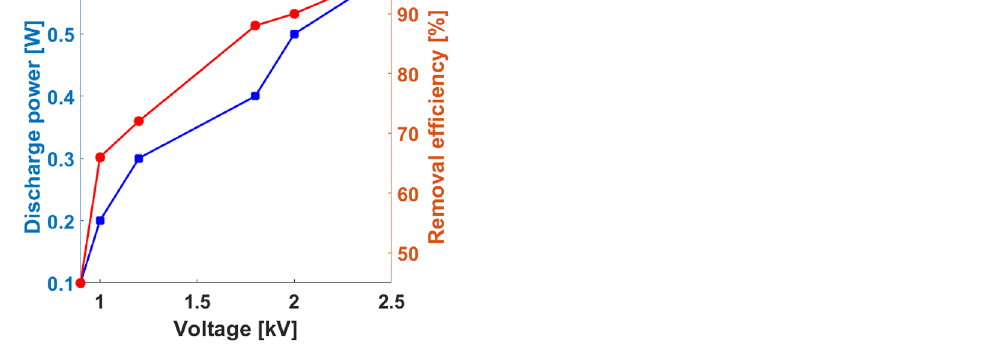
Figure 4. Effect of high voltage supply on ionization discharge power and removal efficiency at ambient